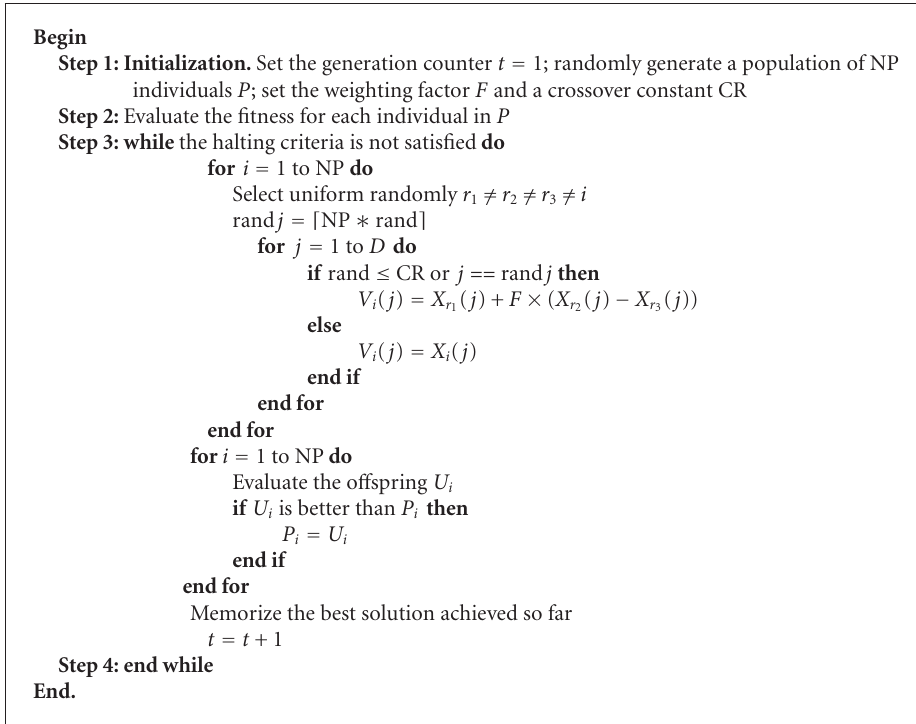
Algorithm 1: Algorithm of DE with DE/rand/1/bin